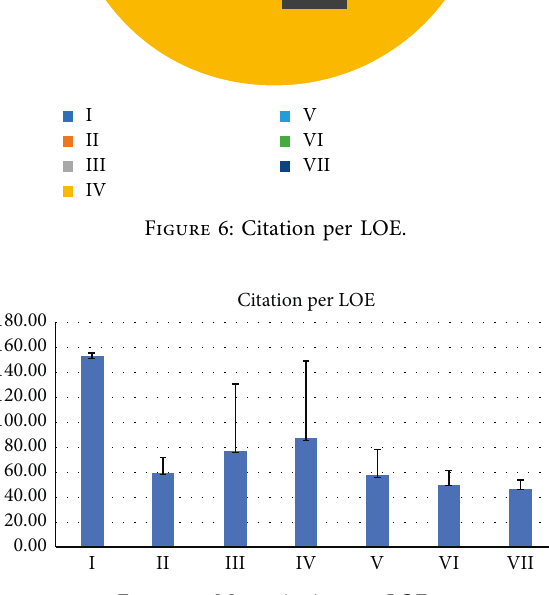
Figure 7: Mean citation per LOE.